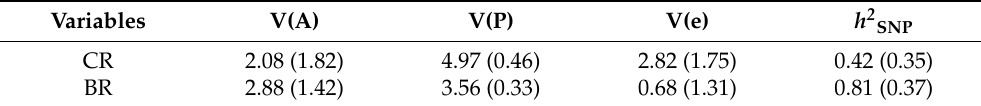
Table 3. Summary results of GCTA. Additive (A), phenotypic (P), residuals (e) variance (V) and SNP heritability ( h 2 SNP ) explained for crown rust (CR) and brown rust (BR) resistance. Numbers between brackets refer to standard